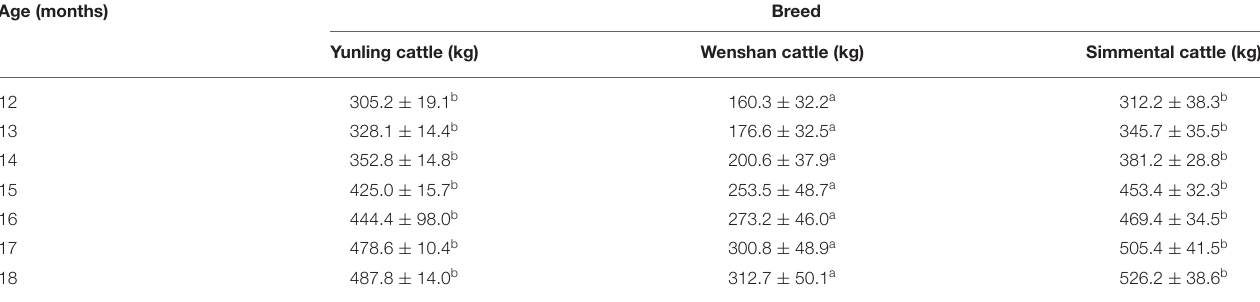
TABLE 2 | Body mass index at different growth periods in three cattle breeds.